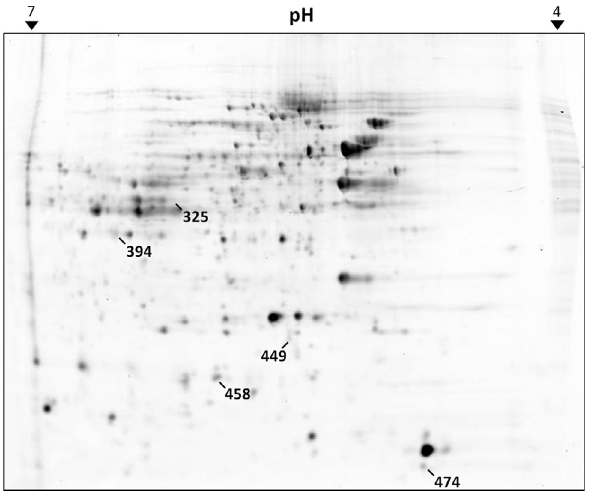
Figure 1 - 2D-DIGE gel of C. violaceum bacteria exposed to a low fre- quency electromagnetic field. The differential spots are indicated by their Match ID. Spot 325 was down-regulated while the others were up-regu- lated. The scale above the gel indicates the pH range used in the first di- mension of